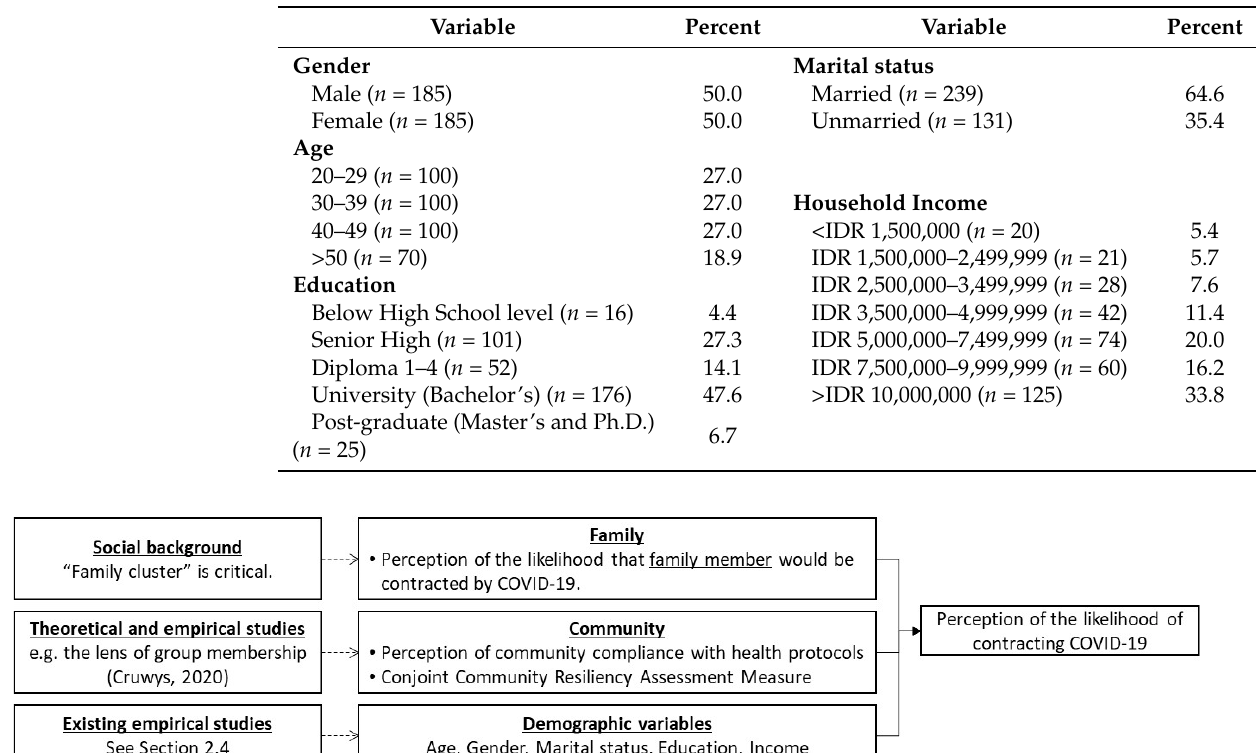
Table 2. Demographic statistics summary ( n = 370).